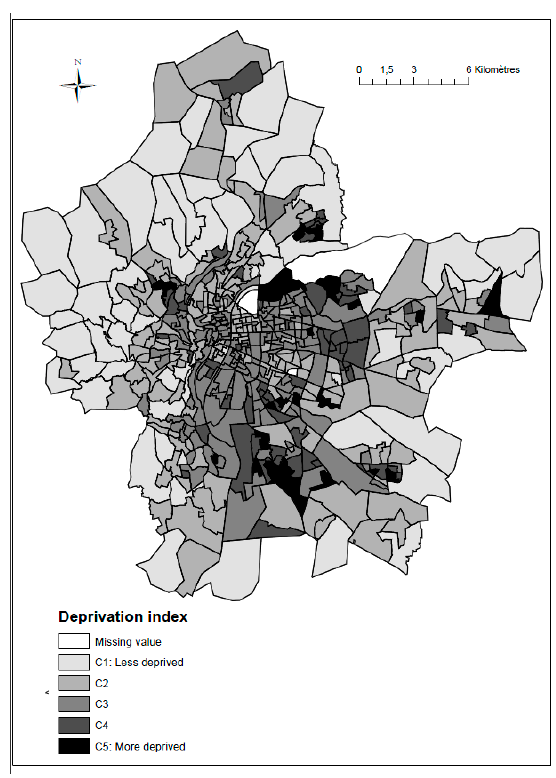
Figure 6. Spatial distribution of the deprivation index, at census block level, based on quintiles of the distribution.